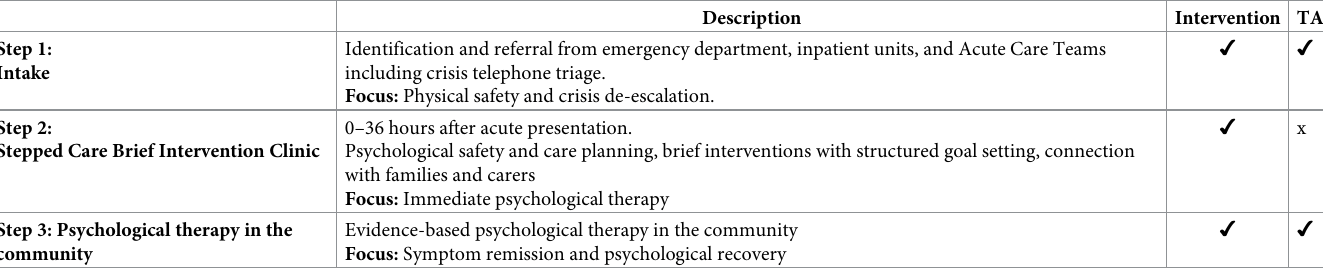
Table 1. Stepped care model (intervention) with comparison to treatment as usual